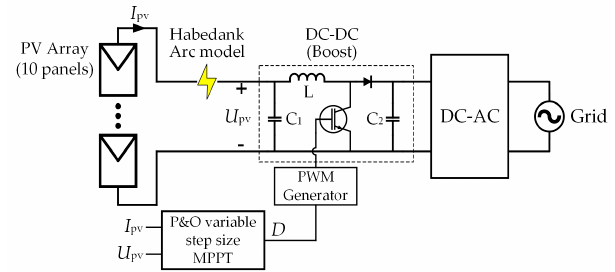
Figure 8. Simulation circuit.